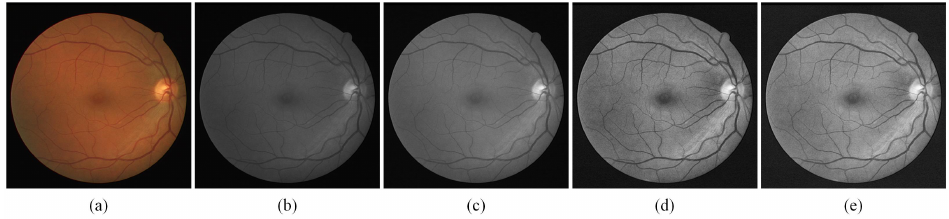
Figure 4. The sample of preprocessing stage. ( a )Fundus image; ( b ) Grayed output result; ( c ) normal- ized output result; ( d ) Output results after CLAHE; ( e ) Output result after Gamma